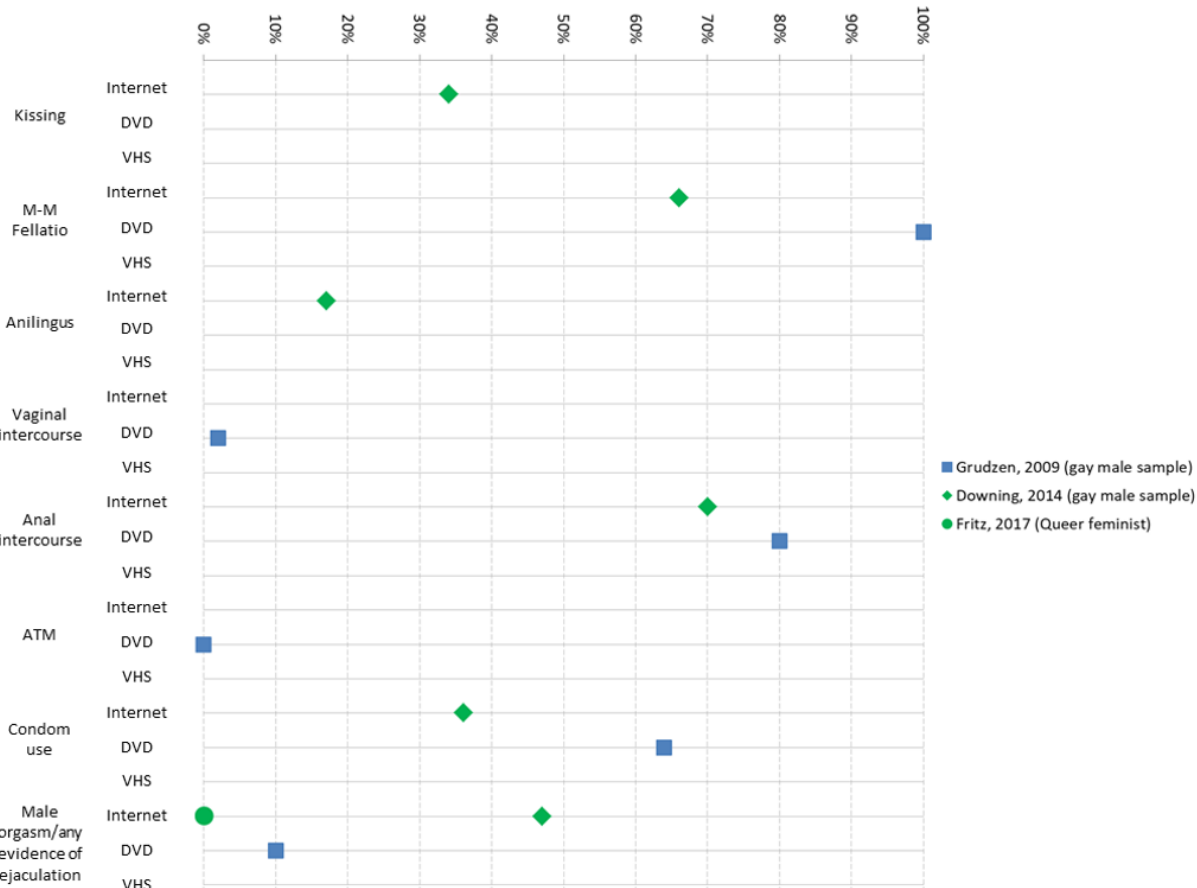
Figure 3. Percentage of gay male/queer samples depicting key sexual behaviors, by medium of pornography (DVD, VHS, or internet-based video), for behaviors studied in these samples. Notes: Results are only presented in this graph if the study presented results by percentage of scenes or videos (ie, studies that presented results by time, mean, character excluded from graph). Paraphilias not presented due to sparse data. Bondage, dominance, and sadomasochism and group sex–related behaviors not presented due to variance in definitions and categories between studies. Ejaculation variable is presented in accordance with any estimate of ejaculation; if reporting multiple positions, the highest estimation is provided in this graph. VHS: video home